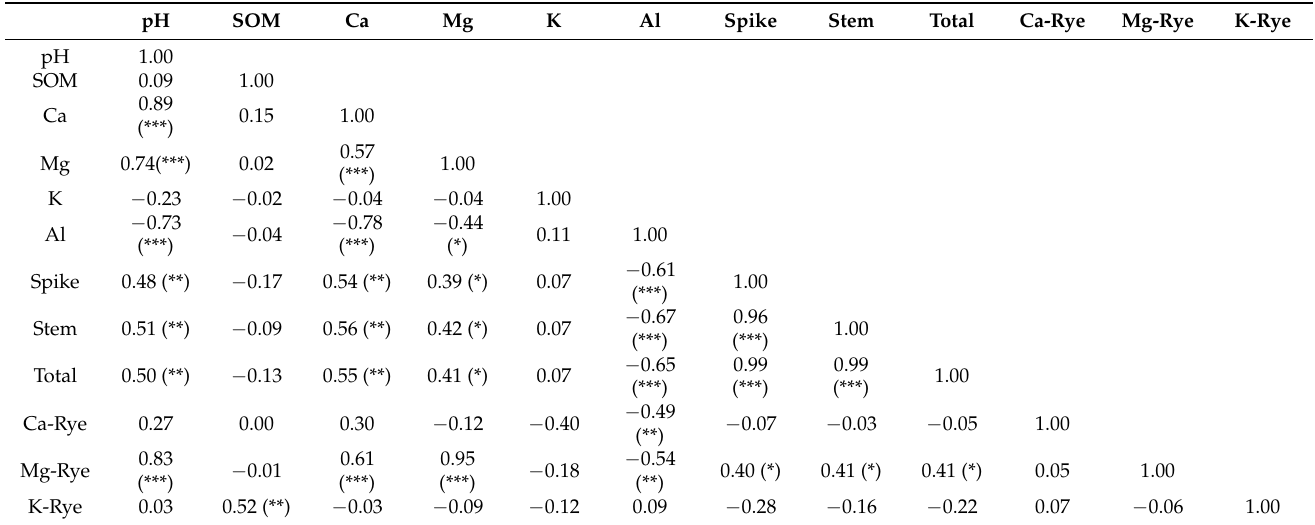
Table 3. Pearson correlations between the Ap1 soil (pH, SOM, Ca, Mg, K and Al) and biomass parameters (spike, stem and total; Ca, Mg and K content in stems (Ca-Rye, Mg-Rye and K-Rye, respectively)) throughout the ten years of monitoring (2002–2011) ( n = 30). The results were significant at * p < 0.05, ** p < 0.01 and *** p <